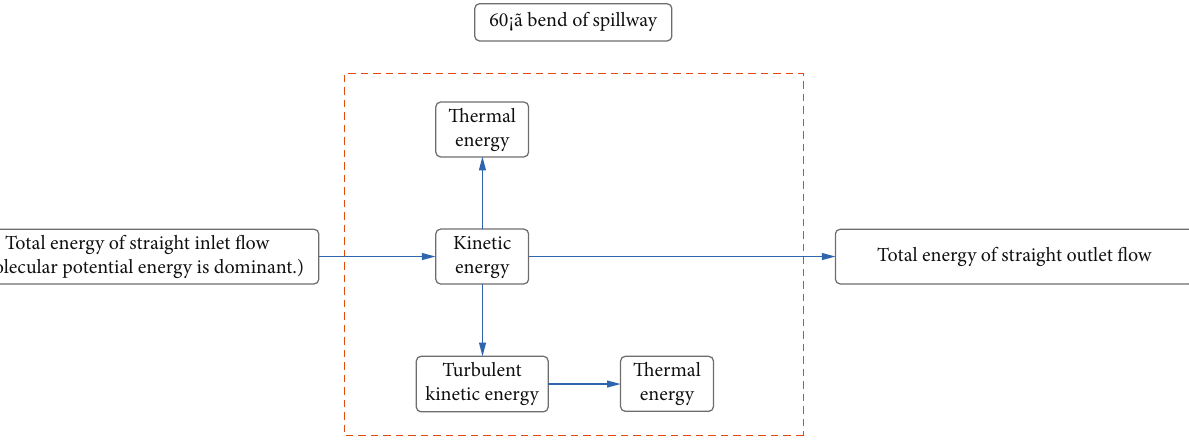
Figure 9: Schematic diagram of the energy dissipation process of the